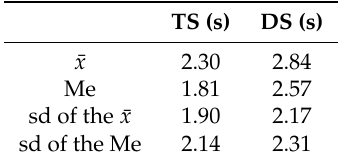
Table 5. Results of the ABD testing for all